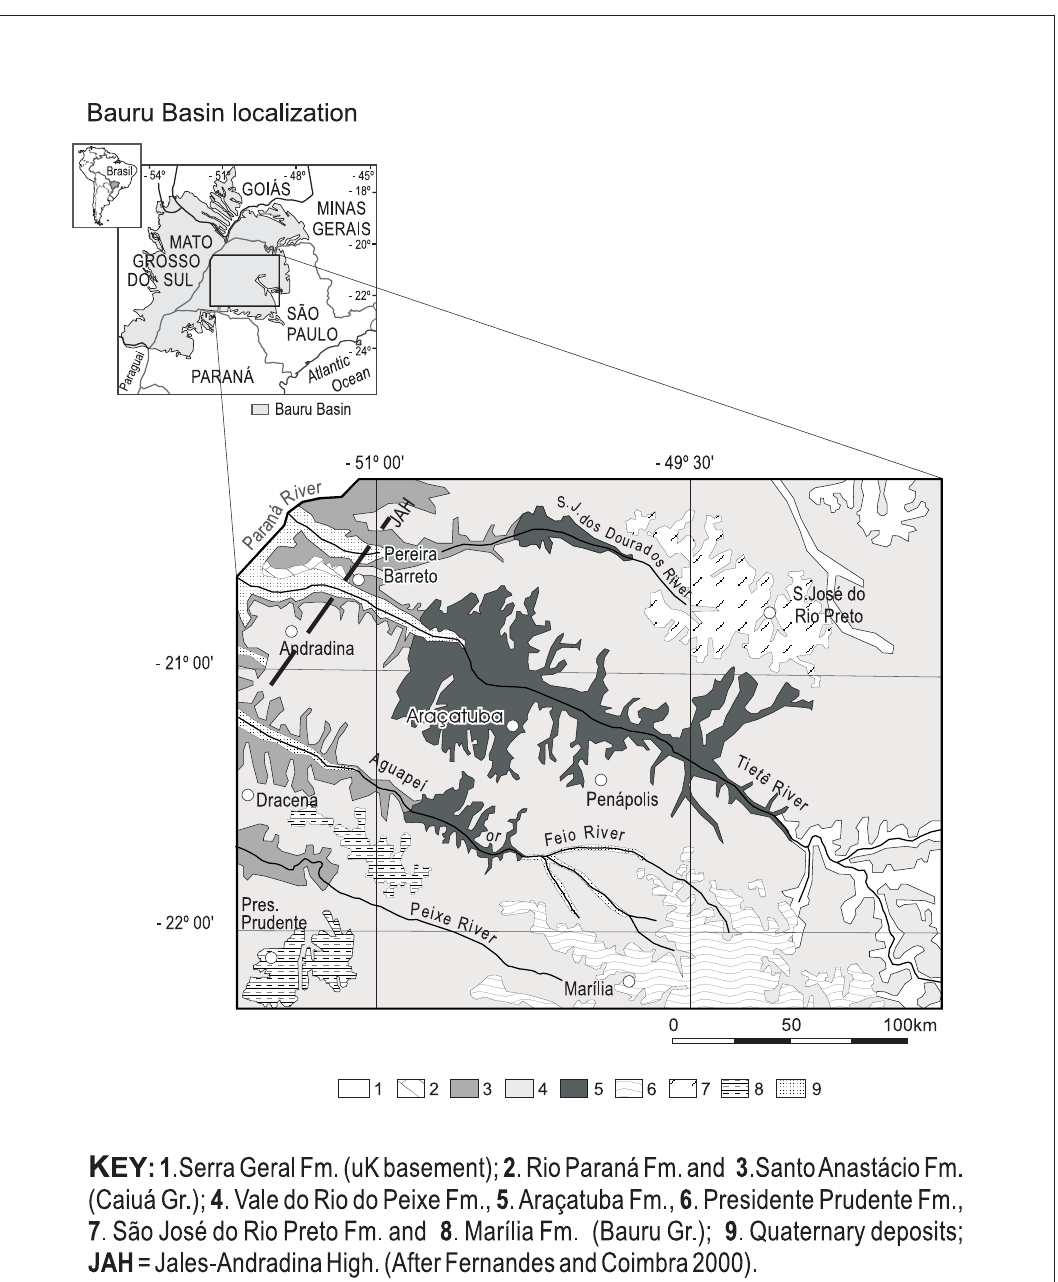
Fig. 1 – Geologic map of the study region and localization of the Bauru Basin (after Fernandes 1998). normal grading to the top and parallel bedding at domorphs were observed (Figure 3d, e and f). Mud the top. Molds and radial-fibrous pseudomorphic cracks, root casts and dish structures are rather com- gypsite crystals as well as probable dolomite pseu- mon in the unit (Figure 4a and